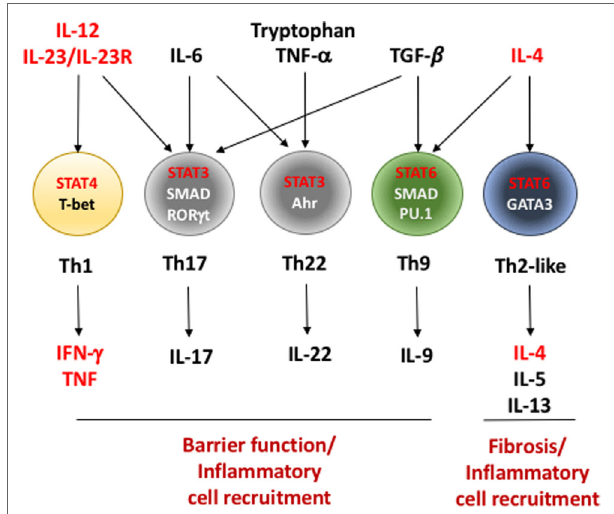
FiguRe 1 | Critical factors in the differentiation of effector Th cells during inflammatory bowel disease (IBD). T helper cells recognize antigen presented in the context of major histocompatibility complex II on antigen-presenting cells in a T cell receptor-dependent fashion (not shown). In conjunction with assorted co-stimulatory signals (i.e., CD80/86–CD28 interaction and others), these signals initiate a program of cell division and differentiation.